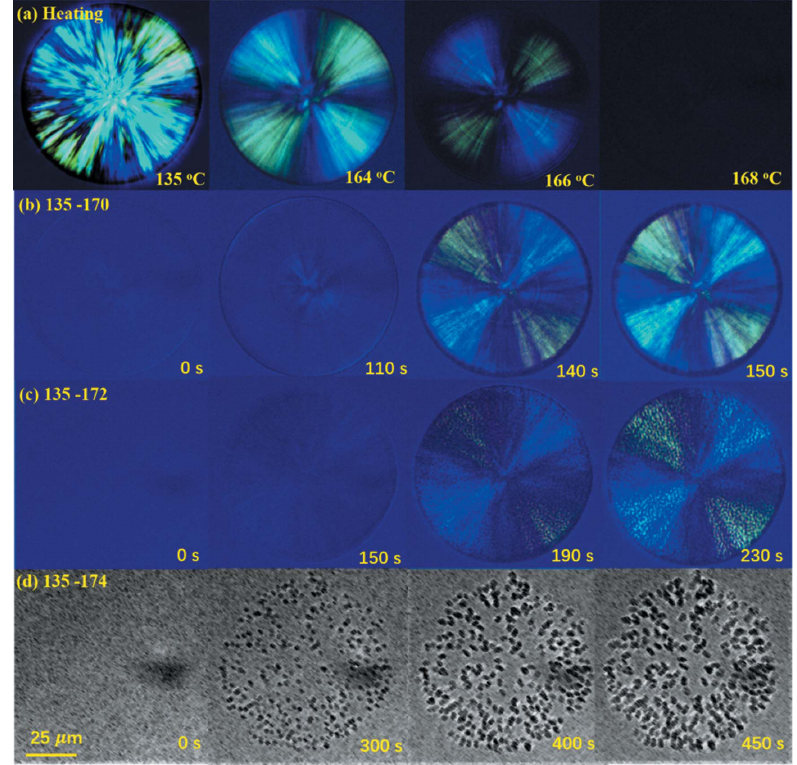
Figure 2 ( a ) Morphological change during heating. The recover processes of spherulites at 135 (cid:3) C after melting at ( b ) 170, ( c ) 172 or ( d ) 174 (cid:3) C. To see the crystal grains in ( c ) clearly, colored images were changed to gray